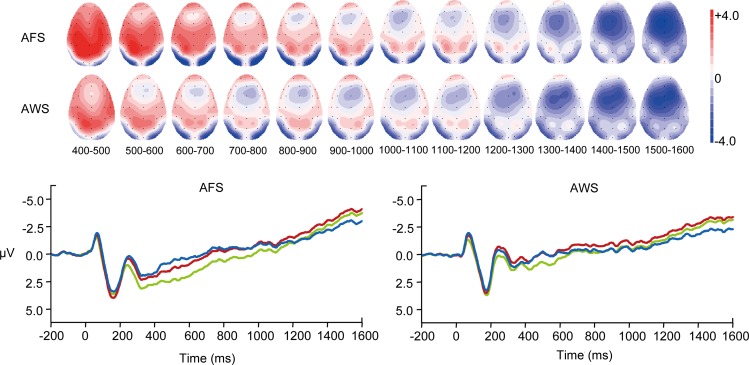
Topographic shifts of the CNV.The top panel presents the scalp voltage distribution of AFS and AWS, and the lower panel displays the mean amplitudes of ERPs at the FZ (blue line), the FCZ (red line) and the CZ (green line).